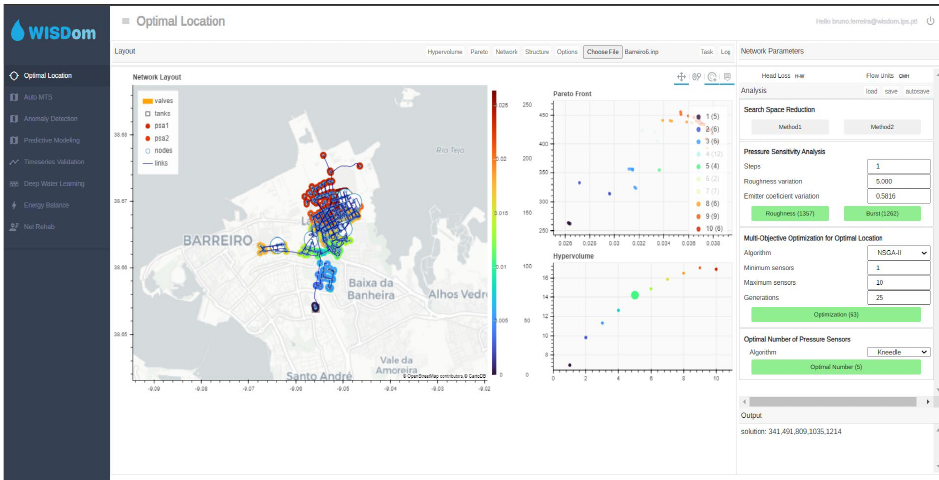
Figure 4. Screenshot of tool for the optimal number and location of the pressure